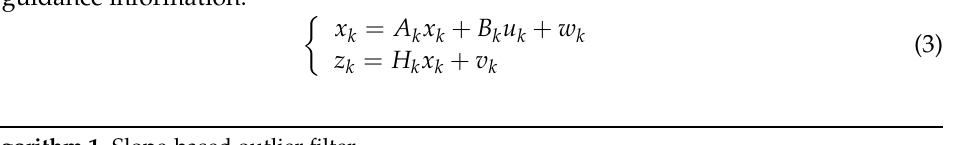
Algorithm 1. Slope-based outlier